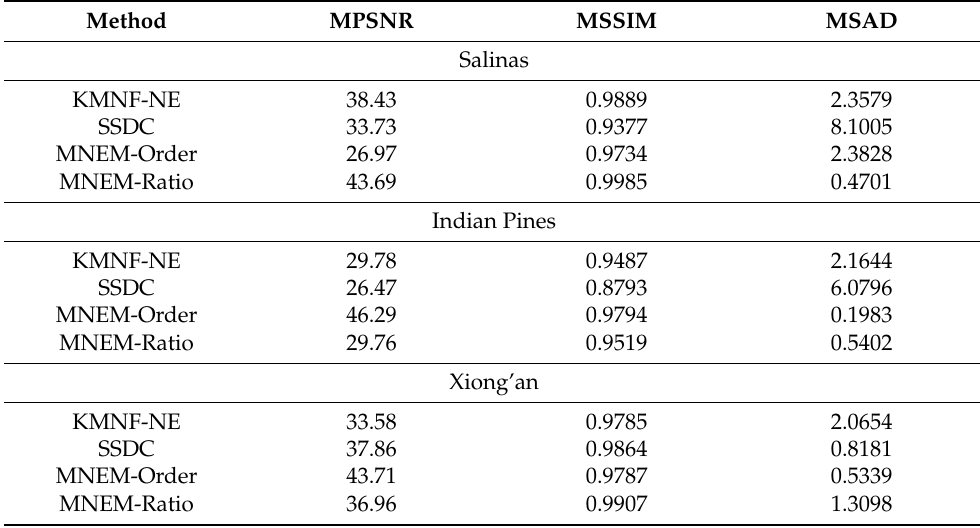
Table 2. Mean peak signal-to-noise ratio (MPSNR), mean structure similarity (MSSIM) and mean spectral angle distance (MSAD) of different methods on Salinas, Indian Pines, and Xiong’an